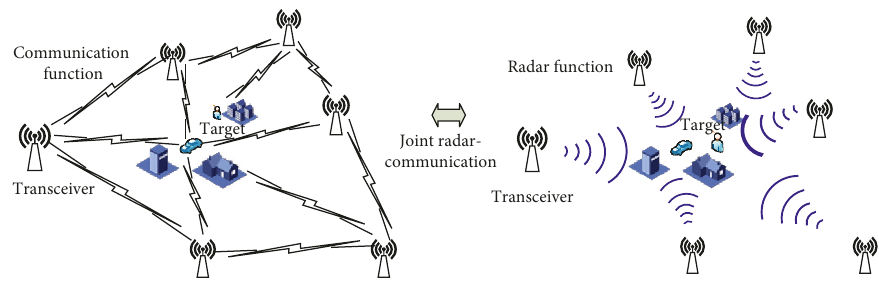
Figure 2: The joint communication-radar